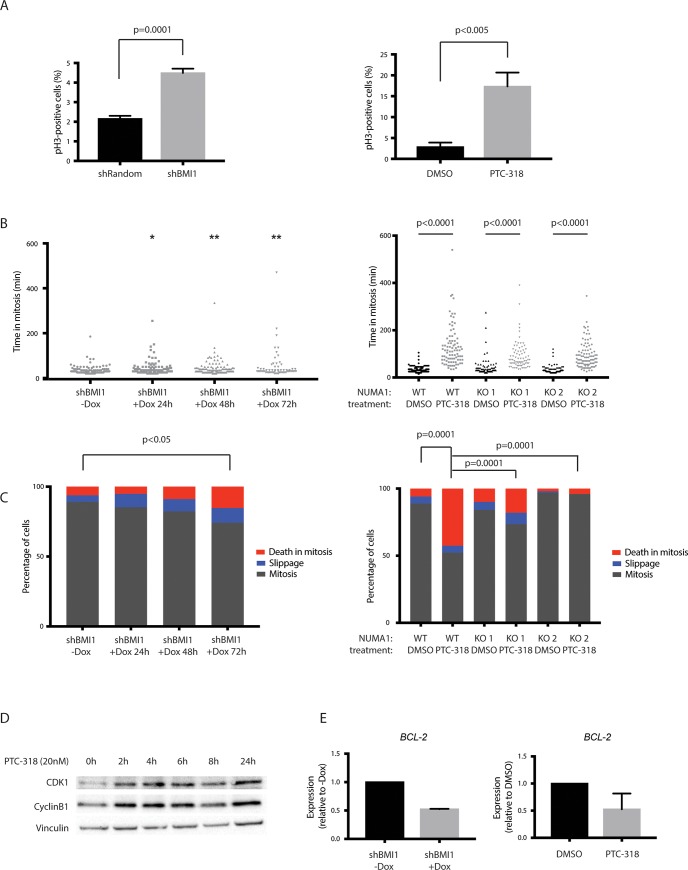
BMI1 inhibition induces mitotic cell death in NUMA1-WT cells but not in NUMA1-KO.(A) Quantification of phospho-histone H3 populations of HAP1 cells transduced with the inducible shRandom or shBMI1 constructs where cells were treated with doxycycline for 96 hours before measurement (left graph), and cells treated for 48 h with 0.1% DMSO or 40 nM PTC-318 (right graph). Error bars represent SD (n = 3). A two-tailed Student’s t-test was performed for statistical testing. (B) Scatter dot plot representation of time in mitosis (from nuclear envelope breakdown to anaphase onset) of HAP1 cells transduced with the inducible shBMI1 construct and treated with doxycycline for 0–96 hours (left graph), or NUMA1-WT and NUMA1-KO cells treated with 20 nM PTC-318 (right). Statistically different means on the left plot are labeled with asterisks *p<0.05 and **p<0.01 (Kruskal–Wallis test). (C) Analysis of the mitotic fates of cells analyzed in B). The graphs depict the percentages of cells in mitosis (dark grey), mitotic slippage (blue), and death in mitosis (red). A chi-square test was performed for statistical testing. (D) Protein expression of CDK1 and CyclinB1 in HAP1 cells at different time points after treatment with 40 nM of PTC-318. (E) Relative expression levels of BCL-2 in HAP1 transduced with inducible shBMI1 construct (with or without doxycycline for 96 hours; left) or treated with 0.1% DMSO or 20 nM PTC-318 for 4 hours (right). Error bars represent SD (n = 3). A two-tailed Student’s t-test was performed for statistical testing.